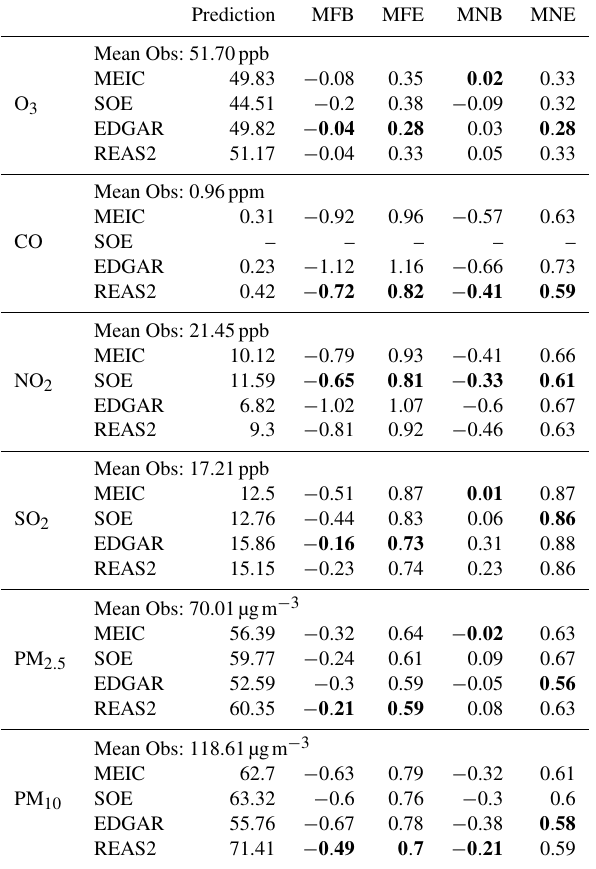
Table 1. Overall model performance of gas and PM species in 2013 using different inventories. Obs is observation, MFB is mean frac- tional bias, MFE is mean fractional error, MNB is mean normal- ized bias, and MNE is mean normalized error. The indices were calculated with hourly observations and predictions. The best per- formance is indicated by the bold